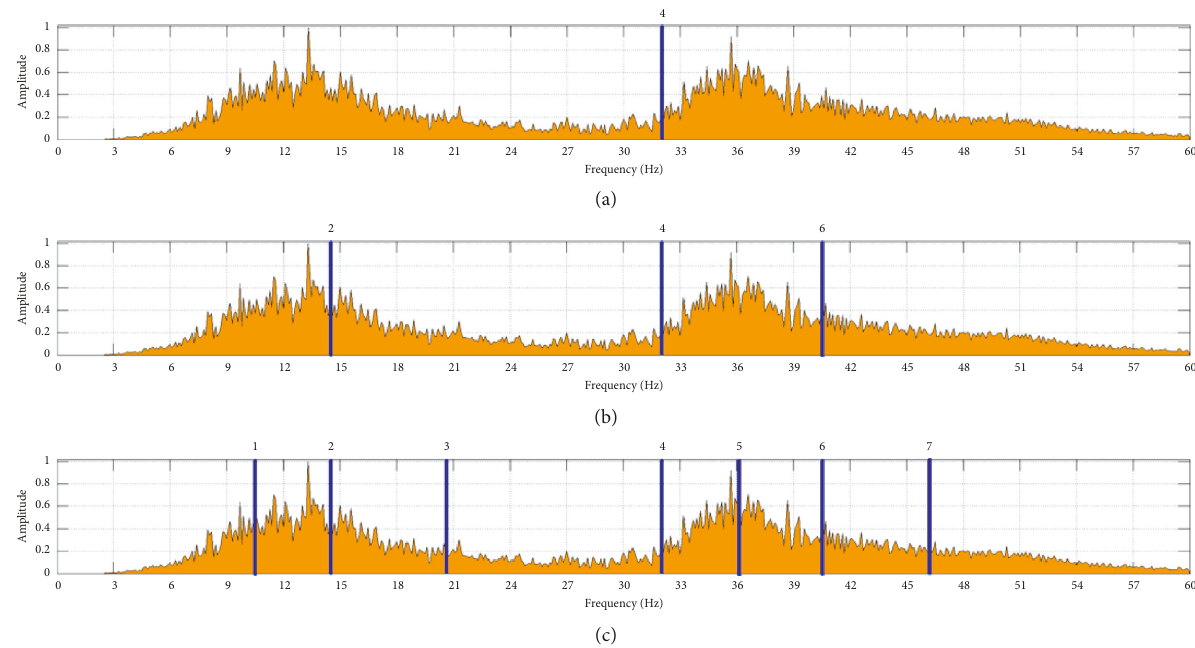
Figure 17: Steps to identify 7